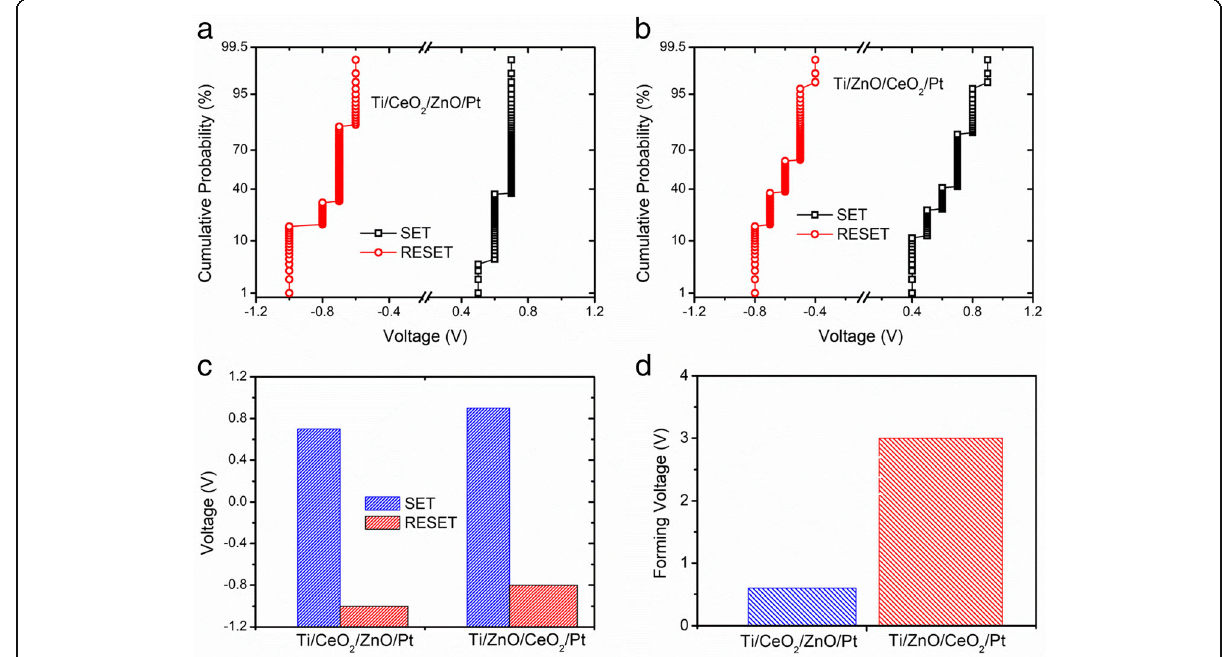
Fig. 3 Cycle-to-cycle cumulative probability distribution of operational voltages in a Ti/CeO 2 − x /ZnO/Pt and b Ti/ZnO/CeO 2 − x /Pt heterostructure memory devices. c Statistical analysis of SET and RESET-voltages of Ti/CeO 2 − x /ZnO/Pt and Ti/ZnO/CeO 2 − x /Pt heterostructure memory devices. d Statistical evaluation of the electroforming voltages for both Ti/CeO 2 − x /ZnO/Pt and Ti/ZnO/CeO 2 − x /Pt heterostructure memory